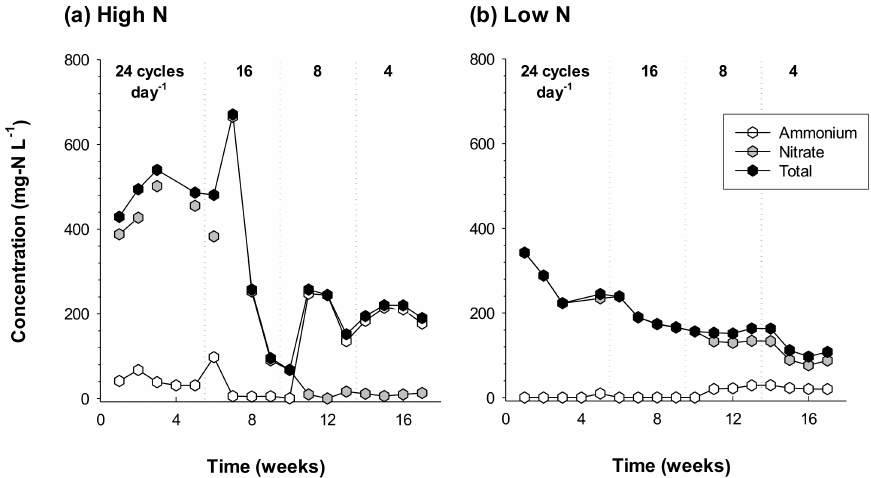
Figure 5. Concentration of ammonium (NH 4+ ), nitrate (NO 3 − ), and total inorganic N in the reservoir fluid associated with the High-N ( a ) and Low-N ( b ) reactors. Vertical dashed lines separate each cycling treatment. The x -axis presents time (in weeks) since the start of the experimental manipulations (i.e., after the six-month equilibration